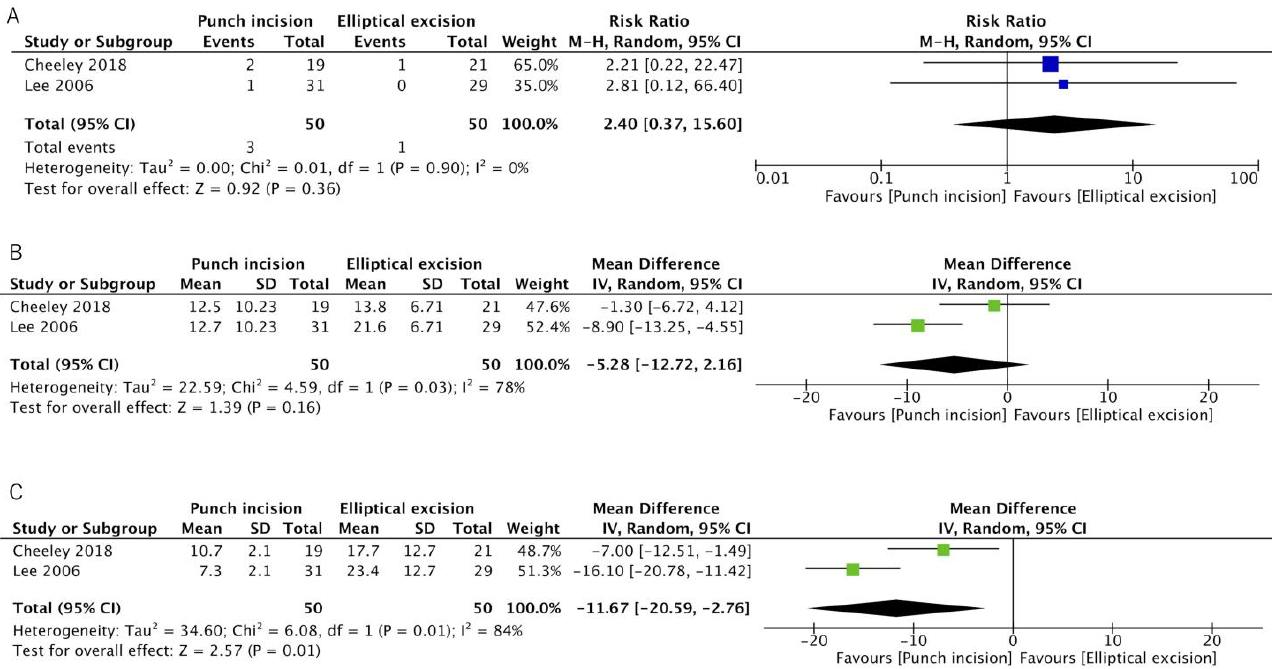
Figure 2. Forest plots. ( A ) recurrence rate, ( B ) mean operative time, and ( C ) mean postoperative wound length.